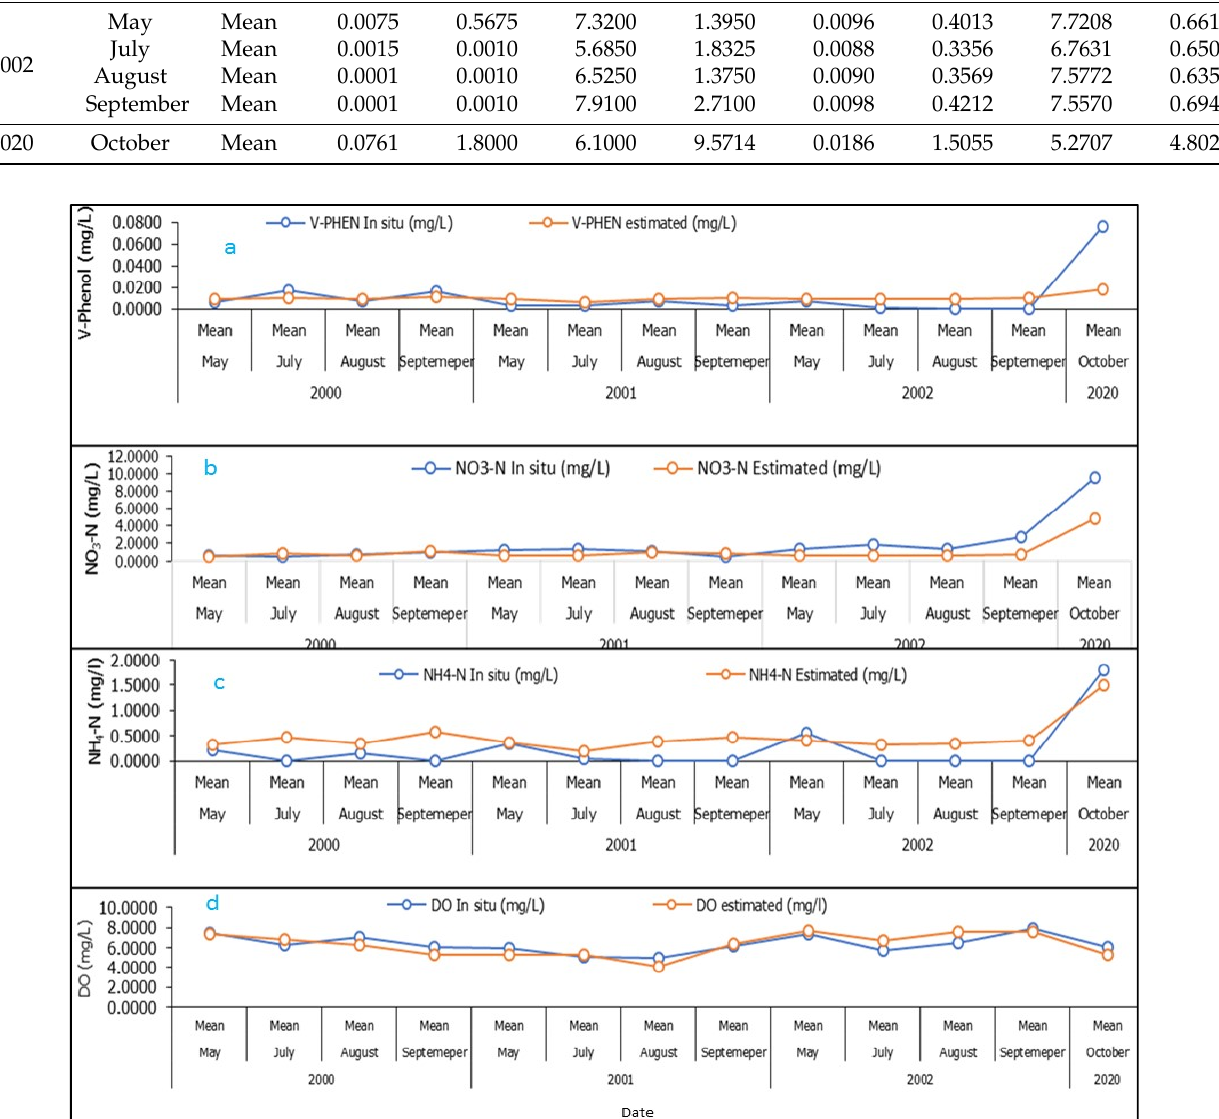
Figure 4. The trend of laboratory-measured results (( a ) V-phenol, ( b ) NO 3 -N, ( c ) NH 4 -N, and ( d ) DO), and model results for water parameters in Erlong Lake.